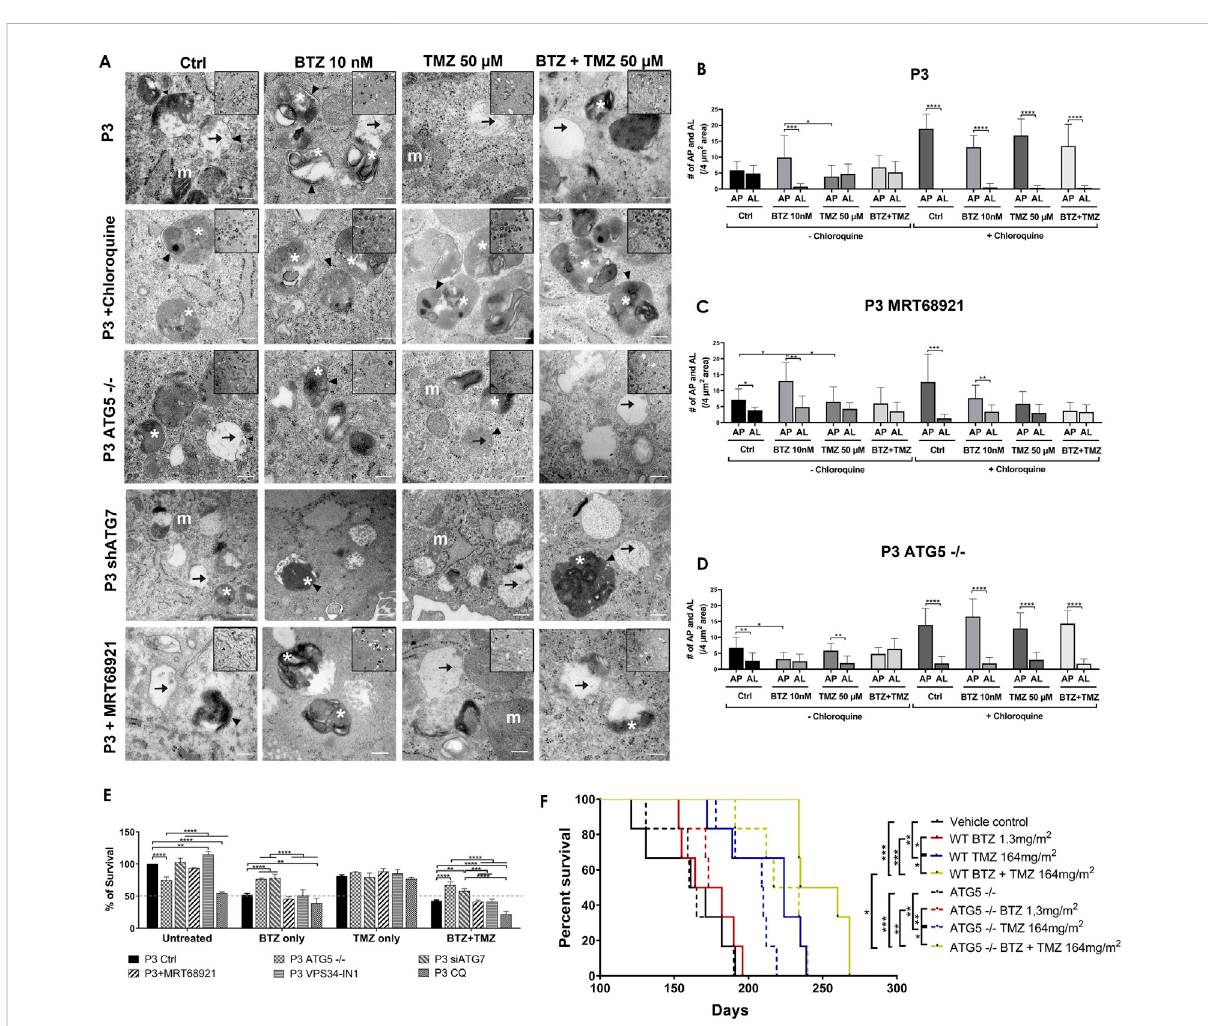
FIGURE 5 Targeting autophagy diminishes tumour cell survival (A) Transmission electron microscopy of untreated, BTZ or TMZ monotherapy and BTZ + TMZ combination treated P3 ctrl cells, ATG5 − / − P3 cells and ATG7 knockdown P3 cells as well as P3 cells treated with chloroquine and MRT68921, scale bar 200 nm, magni fi cation 50K. Inserts 20K magni fi cation. Arrowhead = . double membrane, white asterix = autophagosomes, arrow = autolysosomes and m (white) = mitochondria. (B – D) The number of autophagosomes and autolysosomes were counted from at least 10 cells